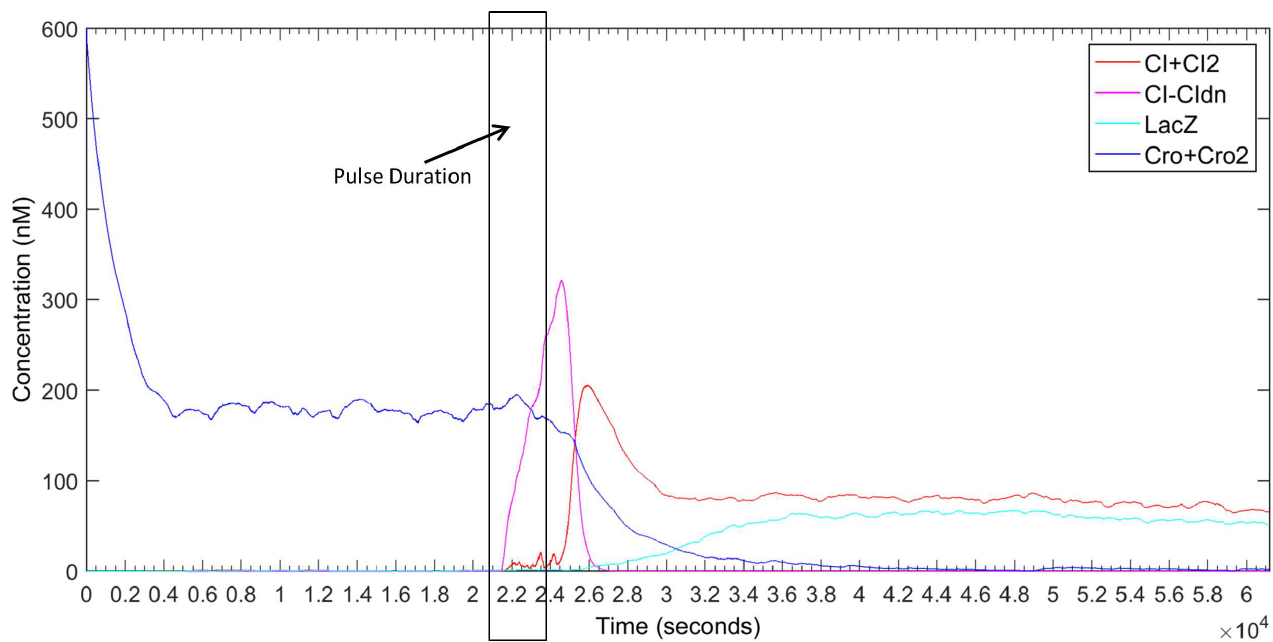
Fig 7. Averagesimulation of the 1 bit pulse counter circuit. The circuit was simulatedfor 30 bacterialCC (30X34 minutes). The durationof the pulse was 1.5 CC (1.5X34 minutes) and was activated at 10.2 CC (10.2X34minutes).